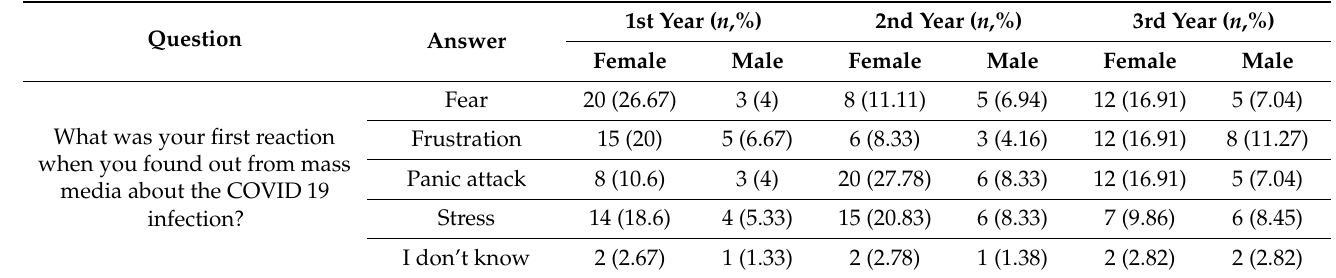
Table 2. Results from the questionnaire on mental, physical and behavioral symptoms caused by COVID-19